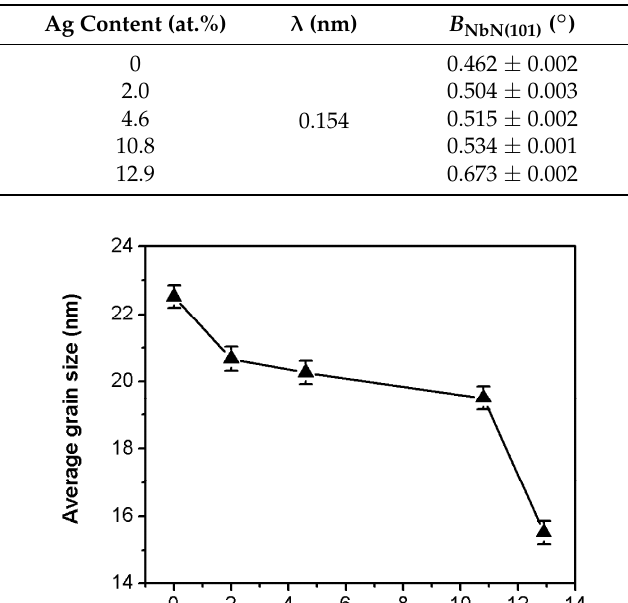
Table 1. The values of λ and B obtained from XRD patterns.